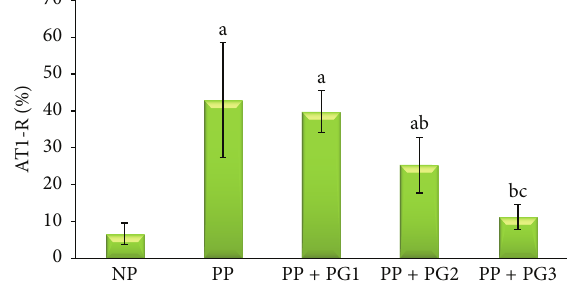
Figure 1: The endothelial expression of Angiotensin-II Type I receptor was measured by immunohistochemistry technique. The data represents 5 replicated experiments (mean value ± SD), a 𝑃 < 0.05 in comparison with endothelial cells exposed to 2% plasma from normal pregnancy (NP) group; b 𝑃 < 0.05 in comparison with endothelial cells exposed to 2% plasma from preeclamptic patients (PP) group; c 𝑃 < 0.05 in comparison with first dose (14ppm) Punica granatum